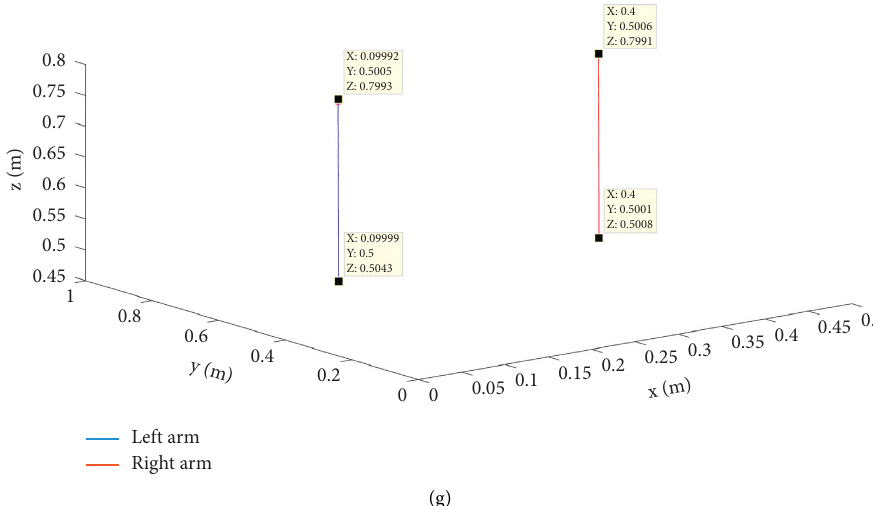
Figure 10: The joint information of dual arm and the end-effector trajectory in Gazebo. (a) Joint angular error of the left arm. (b) Joint angular velocity error of left arm. (c) Joint torque of left arm. (d) Joint angular error of right arm. (e) Joint angular velocity error of right arm. (f) Joint torque of right arm. (g) End trajectory of dual